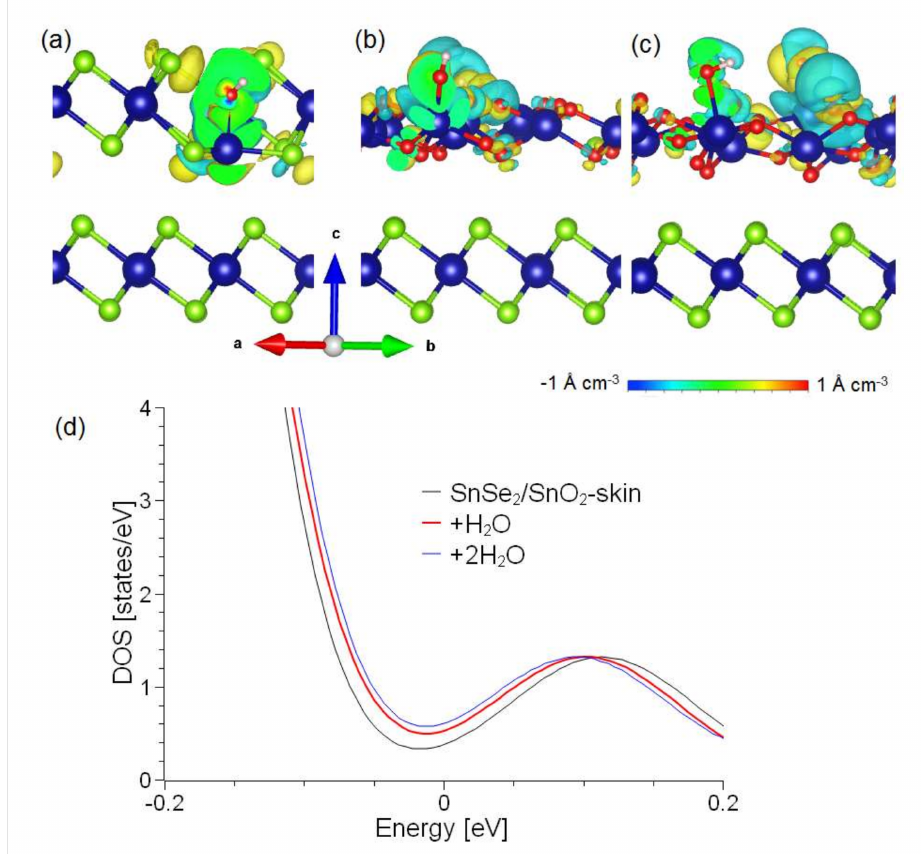
Figure 8. Panels ( a - c ) report the change of the charge density after adsorption of one water molecule on SnSe 2 , one water molecule on SnO 2 -skin-terminated SnSe 2 , and two water molecules on SnO 2 - skin-terminated SnSe 2 , respectively. Panel ( d ) represents the DOS of SnO 2 -skin-terminated SnSe 2 (black curve) and of the same system modified by the adsorption of one (red curve) and two (blue curve) water molecules. Fermi level is set at